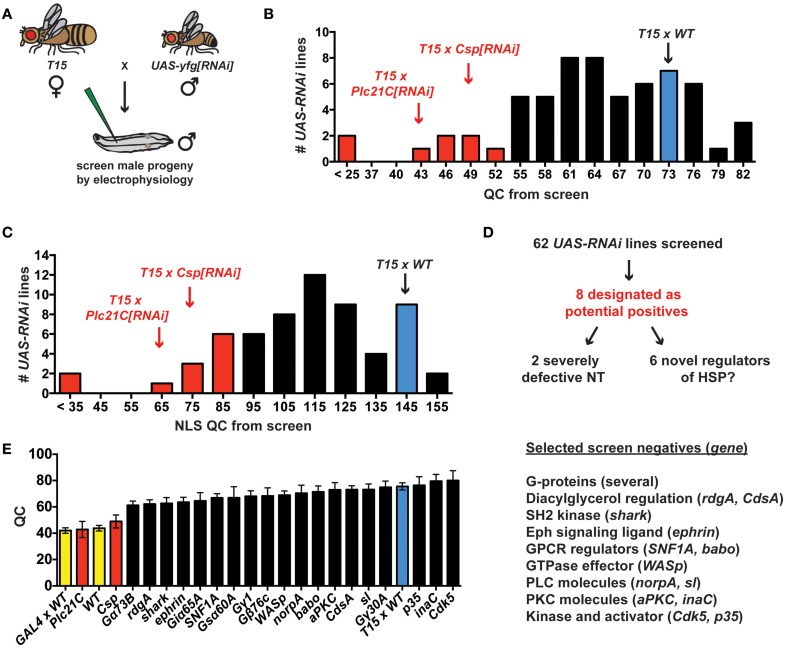
An RNAi- and electrophysiology-based screen for homeostatic factors. (A) Crossing scheme for screen T15 × UAS-yfg[RNAi] (“your favorite gene”). For UAS-RNAi lines on chromosomes II or III, male progeny are examined by electrophysiology because dosage compensated elaV(C155)-GAL4/Y male progeny should have a higher dose of presynaptic GAL4 than elaV(C155)-GAL4/+ female siblings. (B) Distribution of QC values from screened larvae. Eight T15 × UAS-RNAi crosses yield a QC smaller than two standard deviations below T15 × WT (red bars). (C) When QC is corrected for non-linear summation (NLS), twelve T15 × UAS-RNAi line crosses yield an NLS corrected QC (NLS QC) smaller than two standard deviations below WT (red bars). (D) Schematic to sort potential positives for follow-up analyses. (E) Negative data for some genes in the screen. Where a specific gene name is listed, the data represent the QC for T15 × UAS-yfg[RNAi]. Underlying data for displayed screen negatives has average evoked potentials >30 mV (not shown, but WT control EPSP = 33.2 ± 1.0 mV) and QC > 60.